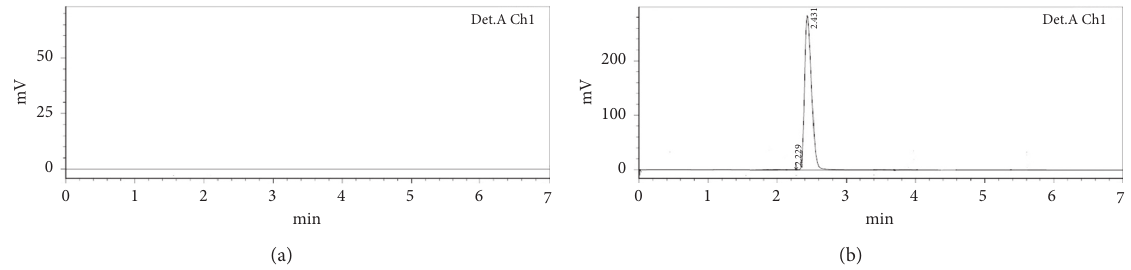
Figure 3: HPLC chromatogram of (a) blank sample and (b) atorvastatin sample.